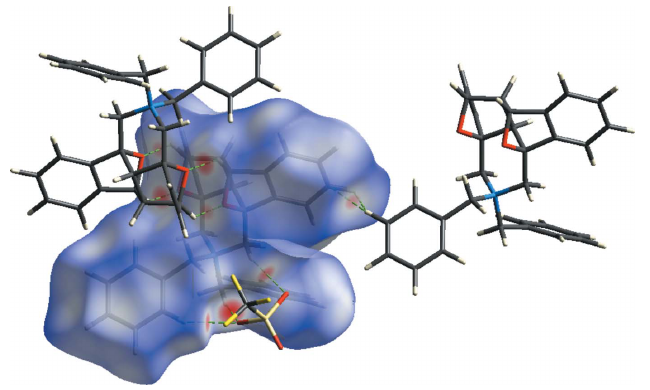
Figure 8 Fingerprint plots showing ( a ) all intermolecular interactions and delineated into ( b ) H (cid:2)(cid:2)(cid:2) H, ( c ) C (cid:2)(cid:2)(cid:2) H/H (cid:2)(cid:2)(cid:2) C, ( d ) O (cid:2)(cid:2)(cid:2) H/H (cid:2)(cid:2)(cid:2) O and ( e ) F (cid:2)(cid:2)(cid:2) H/H (cid:2)(cid:2)(cid:2) F